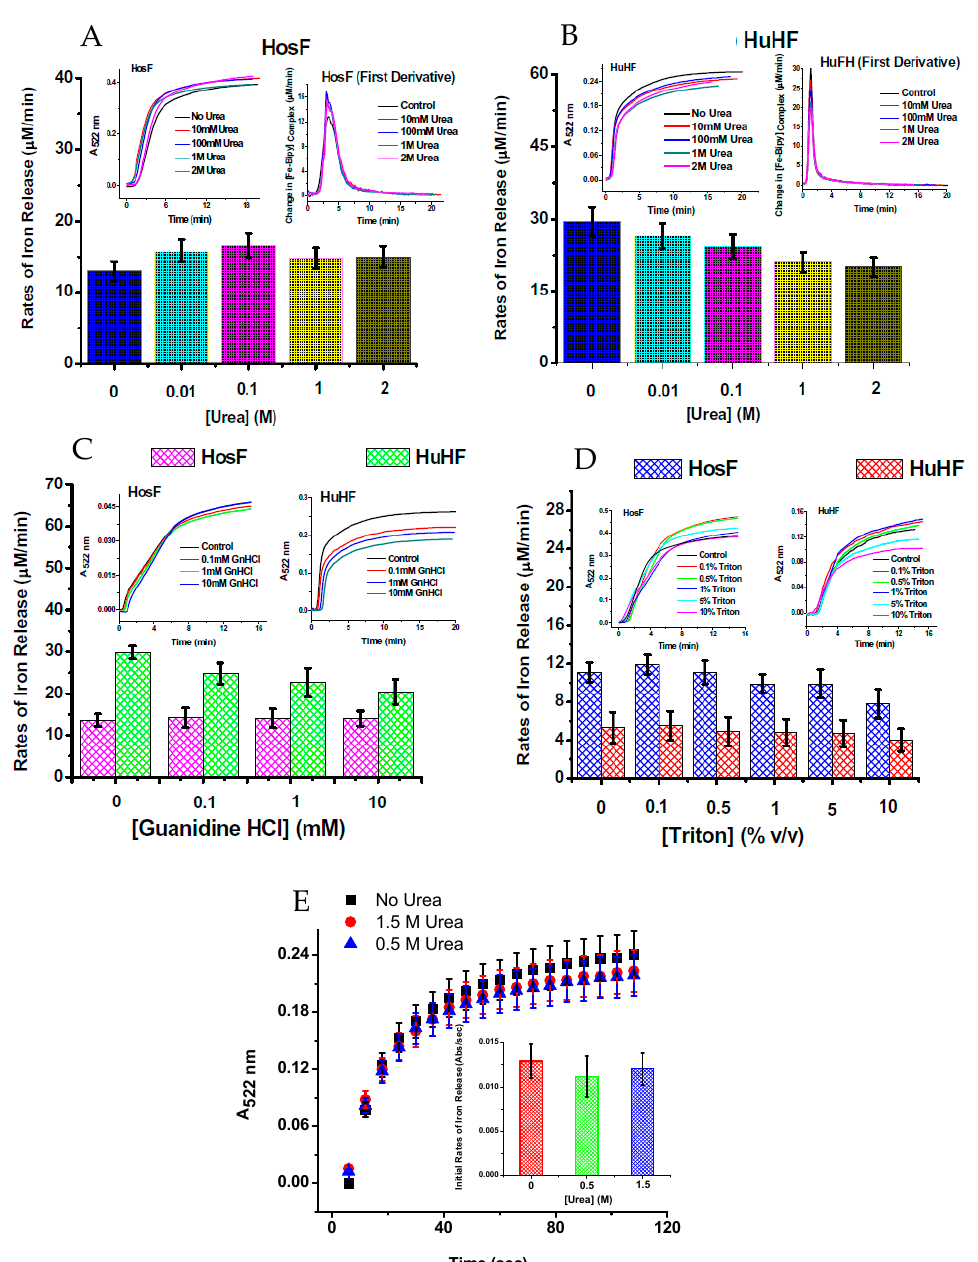
Figure 6. Rates of iron release from HosF and HuHF by the FMN-NADH system ( A – D ), and by FMNH 2 ( E ), in the absence or presence of different concentrations of chaotropes. In both experiments, the presence of urea does not affect the rates of iron mobilization. Reprinted with permission from Ref.